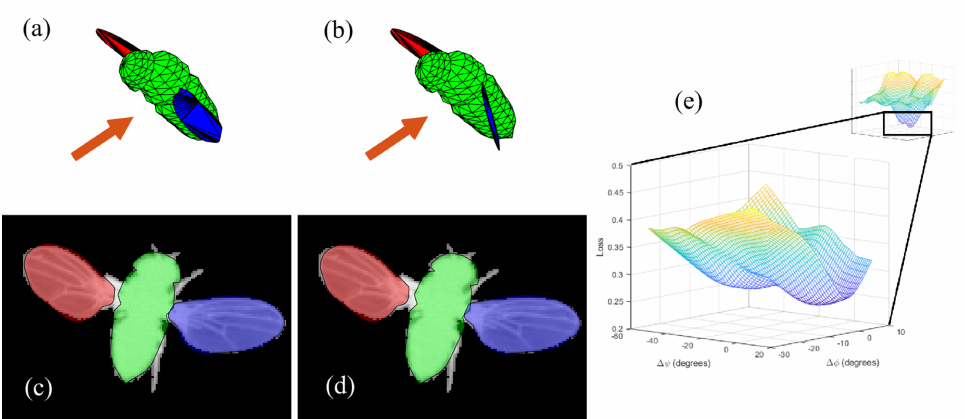
Figure 6. Degeneracy in ψ . ( a , b ) The 3D model generated by two sets of parameters. The orange arrow shows the direction of the camera taking the images on the bottom. ( c , d ) The projection of the corresponding models on the camera plane. The projections are nearly identical. ( e ) The loss function ( z -axis) at the presented frame by changing only ψ (cid:96) and φ (cid:96) ( x -axis and y -axis,